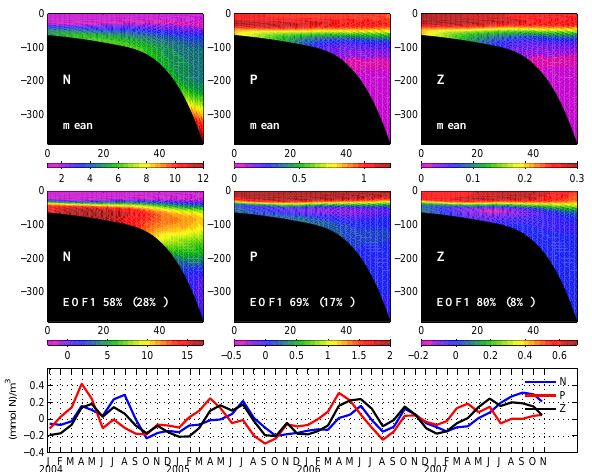
Figure 9. EOF analyses of nutrient, phytoplankton and zooplankton along the 874 Fig. 9. EOF analyses of nutrient, phytoplankton and zooplankton Nantucket transect. Their temporal mean fields are shown on the top panels(units: 875 along the Nantucket transect. Their temporal mean fields are shown (mmol N)/m 3 ), the first EOF modes are shown in the middle panel with the variance 876 on the top panels(units: (mmolN)m − 3 ) , the first EOF modes are they account for (also shown in the brackets are percentages of 2 nd EOF mode 877 shown in the middle panel with the variance they account for (also variance) and the corresponding 1 st principle components are shown at the bottom 878 panels. 879 shown in the brackets are percentages of 2nd EOF mode variance) 880 and the corresponding 1st principle components are shown at the bottom panels.